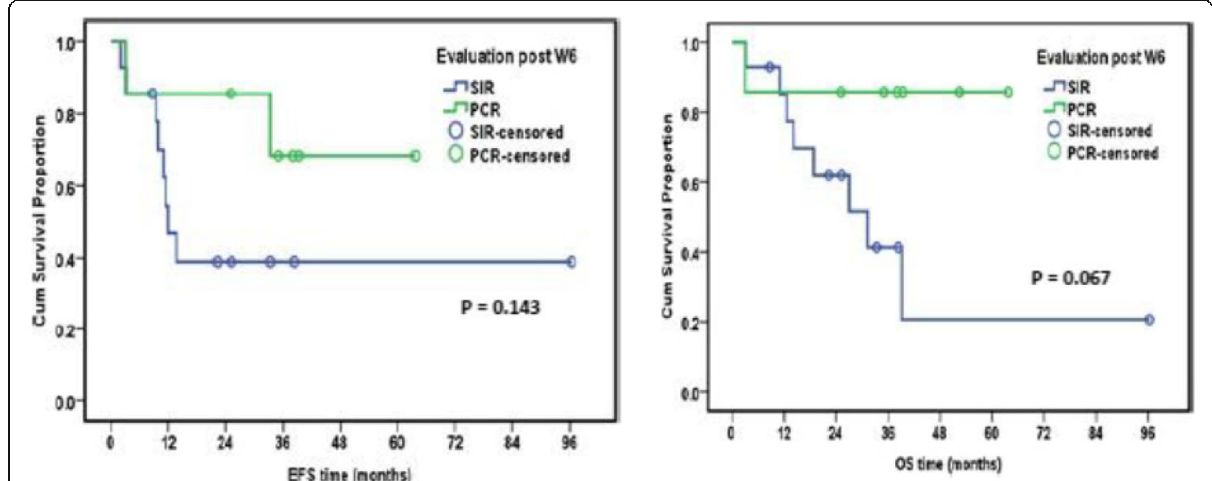
Fig. 6 3-year event-free and overall survival by pulmonary response